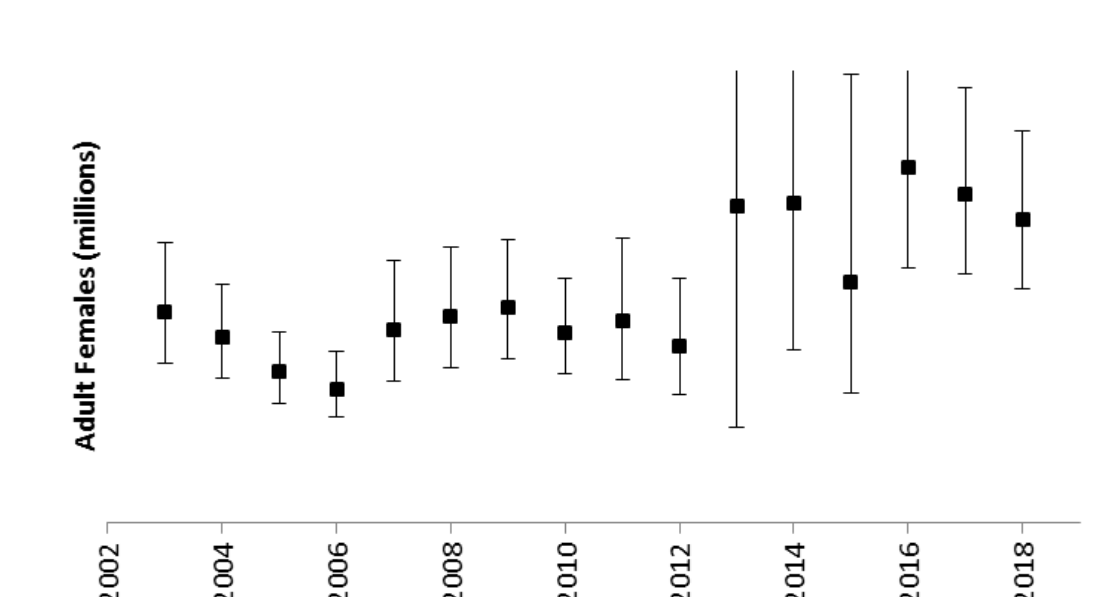
Figure 108. CMSA model estimated adult (primiparous + multiparous) female abundance with lower and upper 95% confidence limits. Upper confidence limits for 2013, 2014, and 2016 extend beyond the y-axis with values of CONFIDENTIAL. Y-axis values have been removed due to CONFIDENTIAL data.